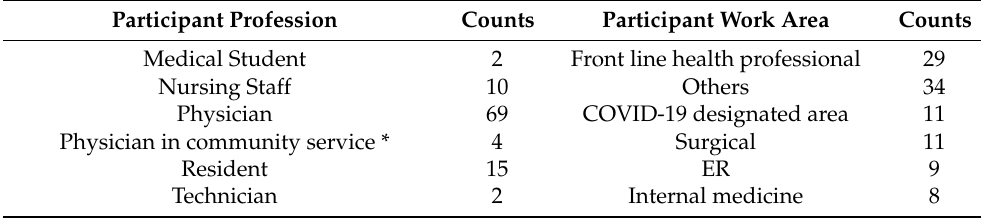
Table 1. Frequency count on participant profession and work area.